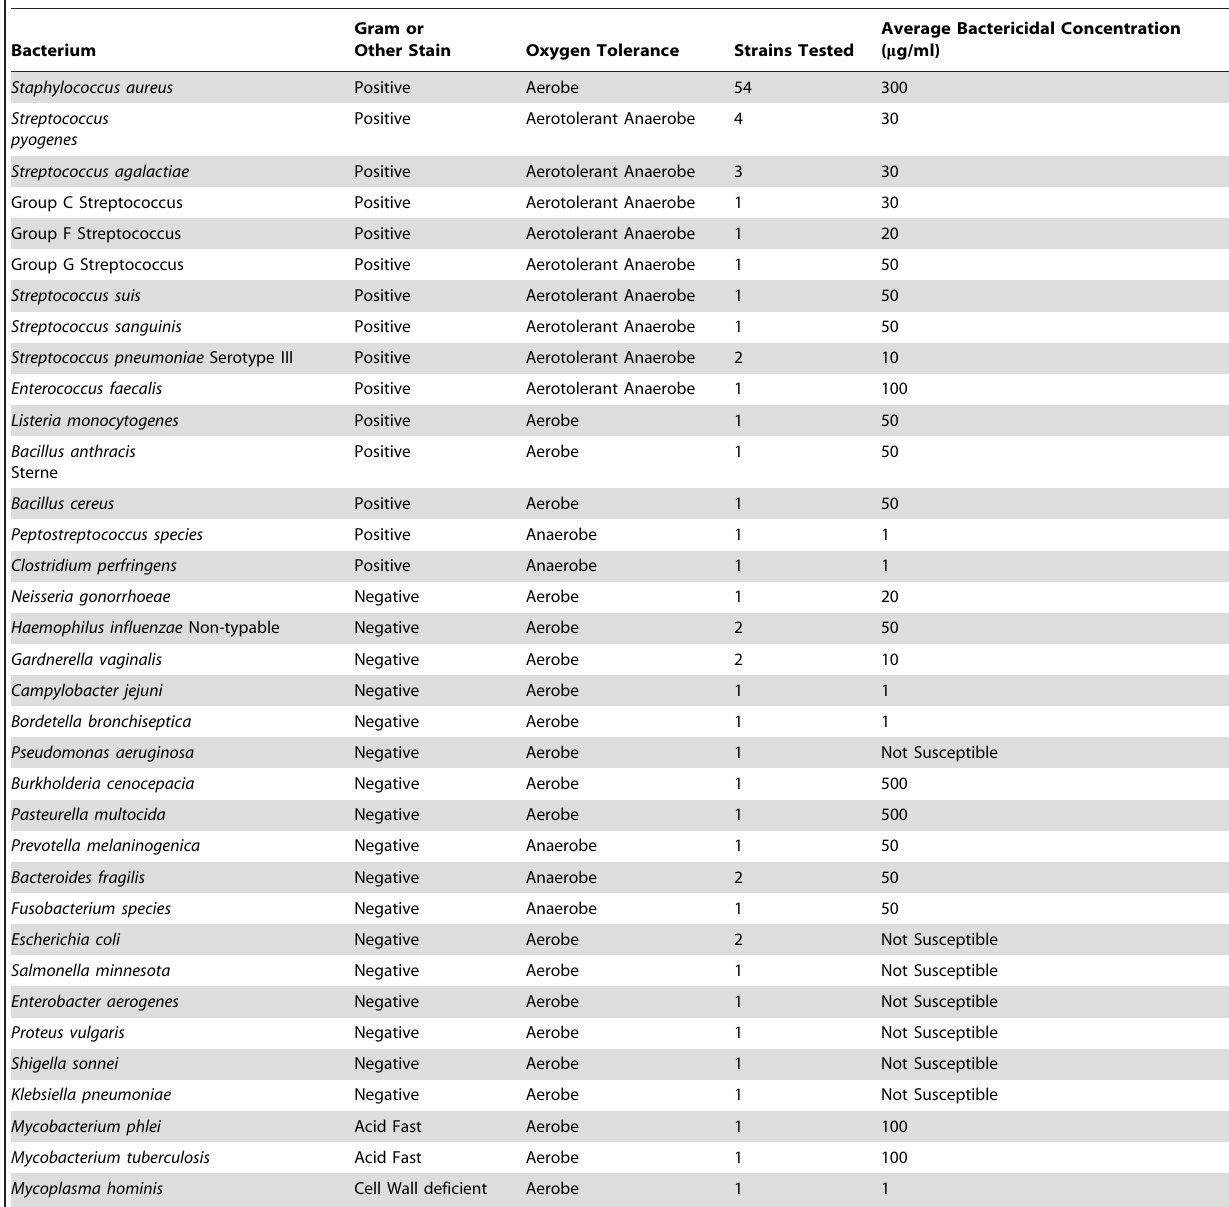
Table 1. Spectrum of antibacterial activity of